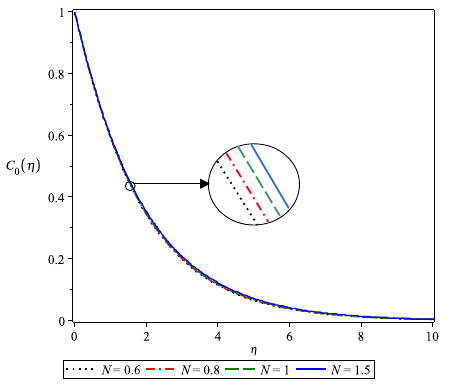
Figure 3. Dependency of concentration profile C 0 on the magnetic parameter N when Sc = 0.24 and K = 0.2.